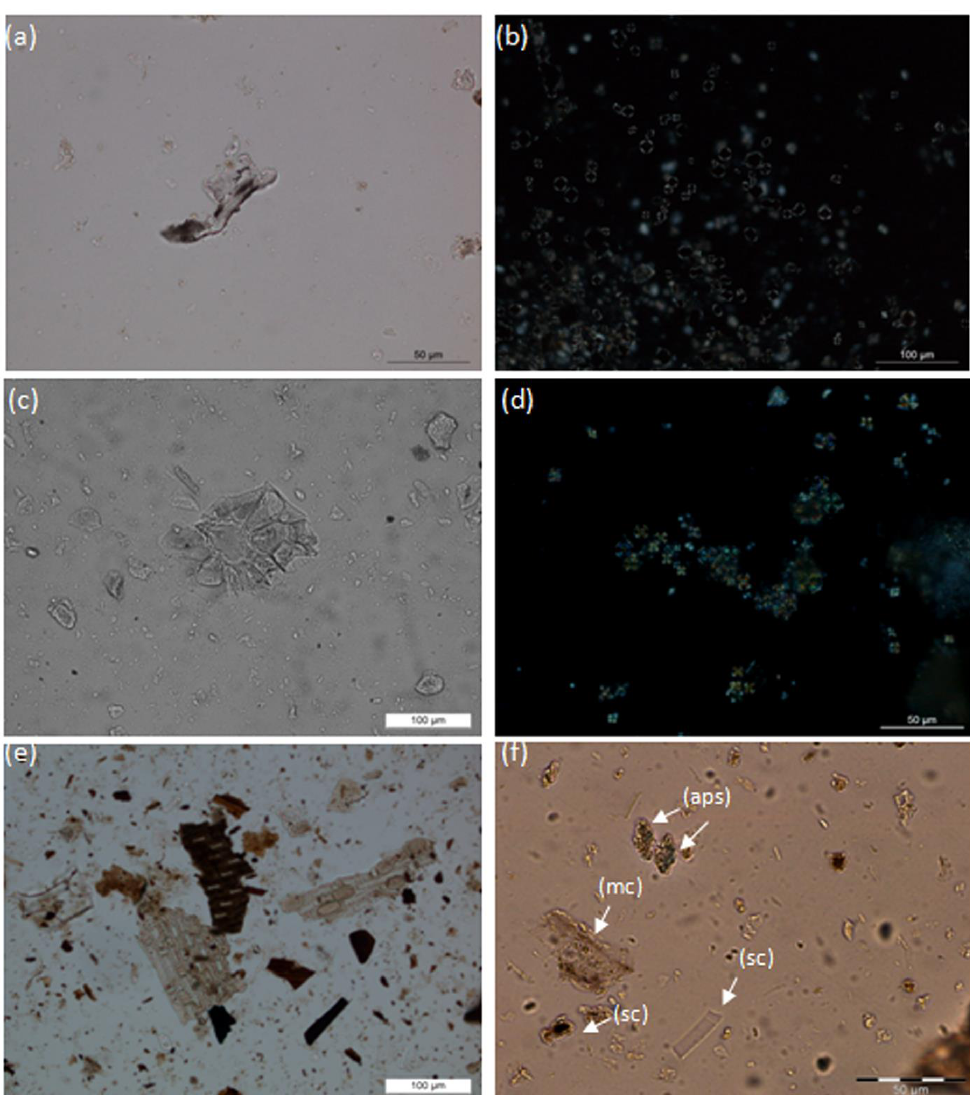
Figure 3. Photomicrographs of phytoliths and calcitic microfossils from modern and archaeological dung samples (200× or 400×). ( a ) Partially melted multicellular (articulated) phytoliths from sheep/goat dung after 800 °C of experimentally produced combustion in a furnace oven, Bestansur, Iraqui Kurdistan (PPL); ( b ) clusters of dung spherulites (mostly darkened), from sheep/goat dung burned at 650 °C in a furnace oven under reducing conditions, Bestansur, Iraqui Kurdistan (XPL); ( c ) epidermal appendage base with attached (articulated) hair from the leaves of dicotyledonous plants from herbivorous penning deposits at early Neolithic Ç atalhöyük, Central Anatolia, Turkey; ( d ) clusters of dung spherulites (none of which are darkened) from the same penning deposits at Ç atalhöyük; ( e ) multicellular (articulated) phytoliths from the leaves and culms of Pooideae grasses and reeds from burnt-herbivore dung deposits at Late Neolithic Pınarbaşı, Central Anatolia, Turkey; ( f ) calcitic wood ash pseudomorphs (coded as aps) along with multicellular phytoliths (mc) and single-celled or individual phytoliths (sc), from mixed woody/ovicaprine dung fuel remains from a modern tannur type ( tabouna ) oven used daily for cooking and baking at El Souidat, northeastern Tunisia.